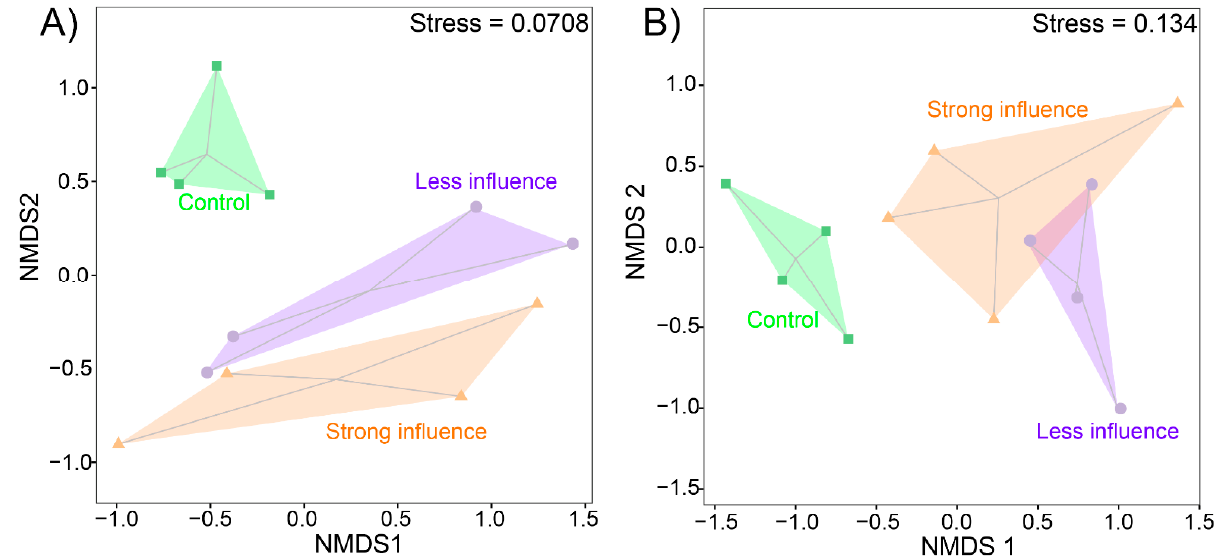
Figure 4. Bacterial ( A ) and fungal ( B ) community compositions as indicated by non-metric multi-dimensional scaling plots (NMDS) of pairwise Bray–Curtis distance in three different Stropharia rugosoannulata cultivation areas. Treatment descriptions are those described in Table 1. Table 4. The tests of significant value of Bray-Curtis distance matrix when comparing the influences of Stropharia rugosoannulata cultivation on soil bacterial and fungal